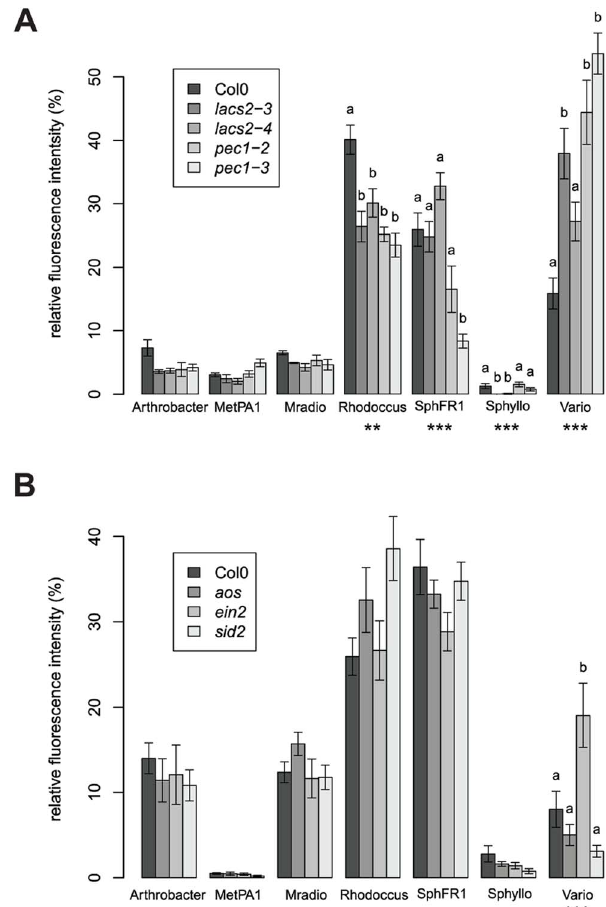
Figure 3. Different community compositions were detected on the cuticle and ethylene mutants. (a) Cuticle mutants (b) Defense signaling mutants. Average ( 6 s.e.m) relative fluorescence intensity (RFI). Asterisks indicate a significant plant genotype effect for the RFI of the bacterial species (*, P , 0.05; **, P , 0.01, ***, P , 0.001; Bonferroni- adjusted P values). Letters indicate a significant effect of the genotype compared to Col-0 ( P , 0.05, Dunnet’s test). There were four (a) and six (b) DNA pools from five plants for each genotype. These experiments were repeated at least in triplicate with similar results. Bacterial species abbreviations: Arthrobacter= Arthrobacter sp. # 968, MetPA1= Methylo- bacterium extorquens PA1, Mradio= Methylobacterium radiotolerans 0- 1T, Rhodoccus= Rhodococcus sp., SphFR1= Sphingomonas sp. Fr1, Sphyllo= Sphingomonas phyllosphaerae , Vario= Variovorax sp.